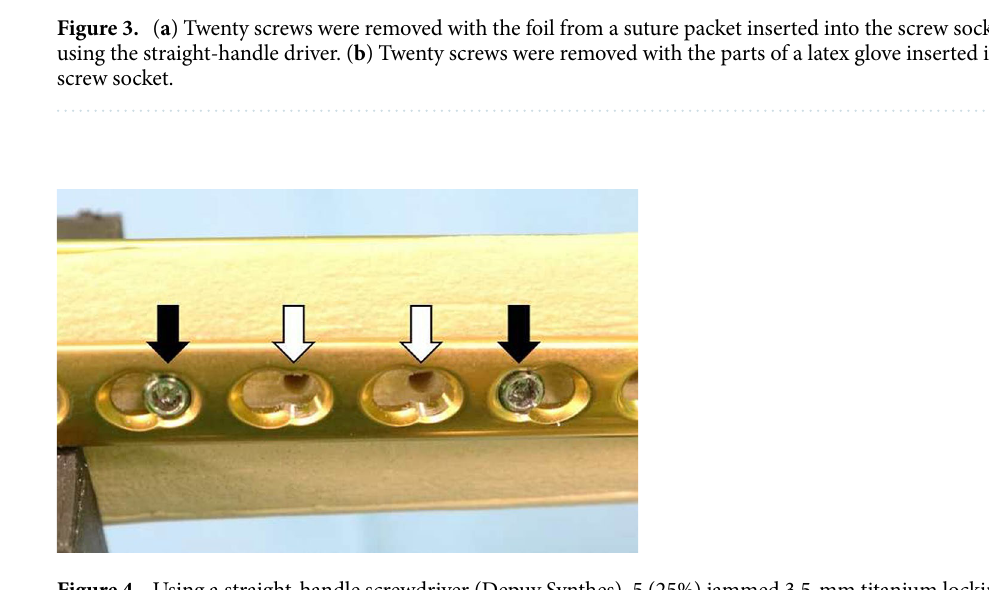
Figure 4. Using a straight-handle screwdriver (Depuy Synthes), 5 (25%) jammed 3.5-mm titanium locking screws (Depuy Synthes) could be removed from the plate (white arrows). However, 15 (75%) screws were stripped and could not be removed (black